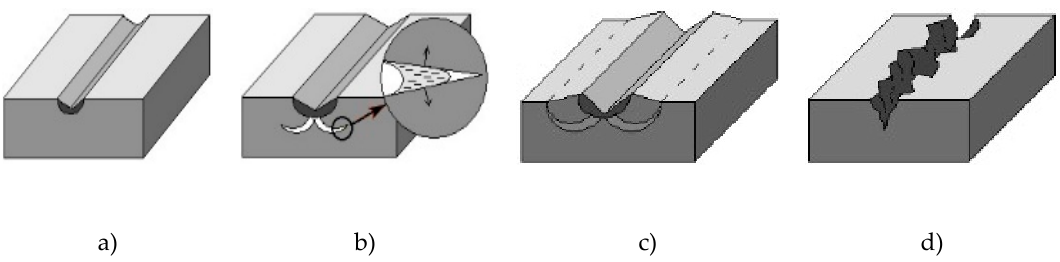
Figure 12. Glass breakage model when scratched: Stage I ( a ), Stage II ( b ), grow of cracks ( c ), formation